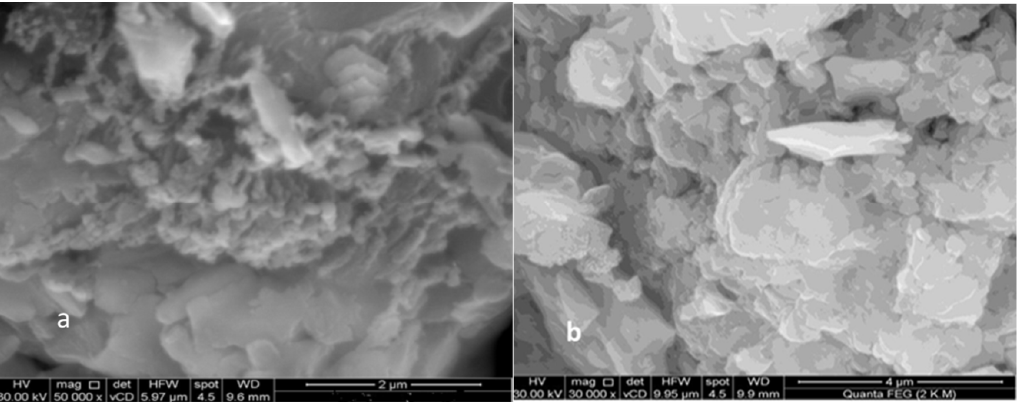
Figure 1. Scanning electron microscope (SEM) of ( a ) Schiff base ligand L and ( b ) Cd(II) complex. The [Cd(L)Cl(H 2 O)]Cl·2H 2 O complex was micrographed, and it showed scattered rods in between the non-uniform platelet formations with varying lateral dimensions. rods in between the non-uniform platelet formations with varying lateral